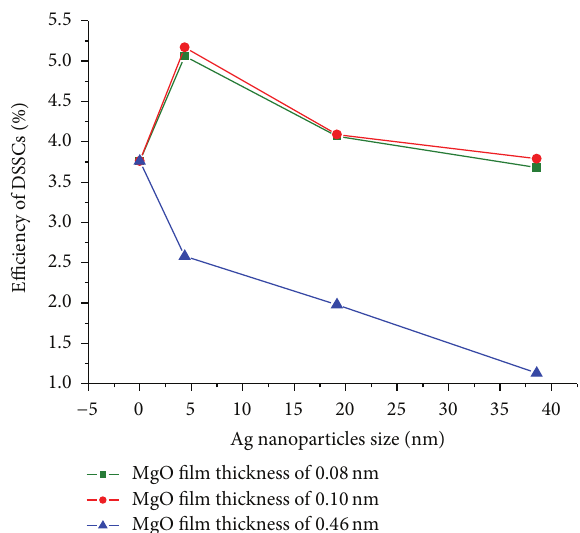
Figure 11: The efficiency of DSSCs with the bare-TiO 2 film and the TiO 2 /MgO/Ag composite films with various MgO film thicknesses in range of 0.08–0.46